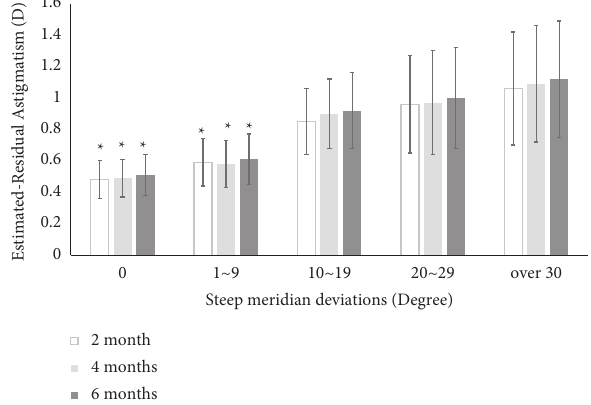
Figure 2: Postoperative estimated residual astigmatism according to steep meridian deviation. Values are presented as mean ± SD. Estimated residual astigmatism D values of 0 (0.48 ± 0.12) and 1–9 °